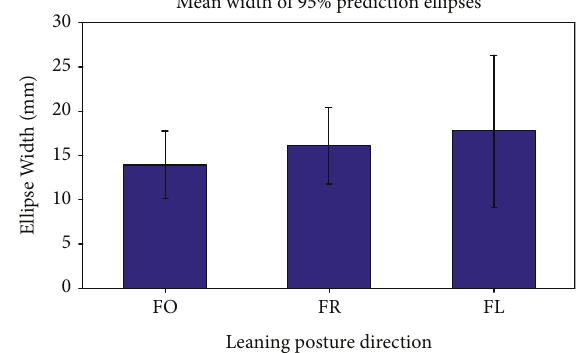
Figure 8: Mean widths of 95% prediction ellipses for CoP-tracking tasks in the forward (FO), forward-right (FR), and forward-left (FL) directions. The error bars are included to indicate ± 1 standard deviation of measurements across twelve